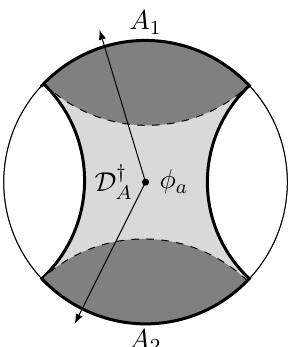
Figure 1 . An operator (cid:30) a , acting on the entanglement wedge a of A = A 1 [ A 2 , can be reconstructed on the boundary region A by the map D y : M a ! M A . The solid interior curves represent the A RT surface of A and the entire shaded region forms the entanglement wedge a (restricted to a single timeslice). The darker gray areas are the entanglement wedges of A 1 and A 2 individually, and also together form the causal wedge of A . Since the operator (cid:30) a is not in the causal